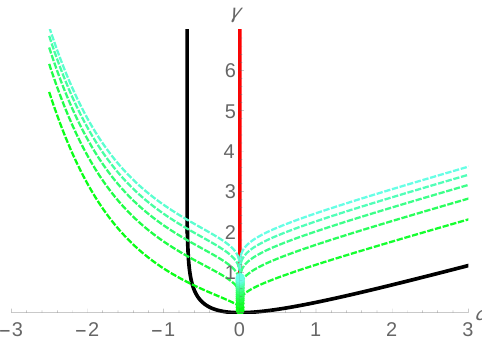
Figure 16 . Location of the (cid:12)rst 10 branches of deformed bars in the ( (cid:13); (cid:14) ) plane. tune both R and (cid:22) R in order to get a solution that extends to in(cid:12)nity both for the negative 0 0 and positive sides of the y axis. This complication can be partially circumvented by noticing that, for the deformed black bars, the change y ! (cid:0) y is equivalent to (cid:22) R means that, if ((cid:10) ; R ; (cid:22) R ) gives an allowed solution, then so does ((cid:10) ; R 0 0 allows the right values of R to be found by requiring the peaks in r 0 located at opposite values of (cid:22) R . This is done by the secant root-(cid:12)nding method in a few 0 iterations. Again, vanishing peaks and fake blobs are discarded in a similar way as in the axisymmetric